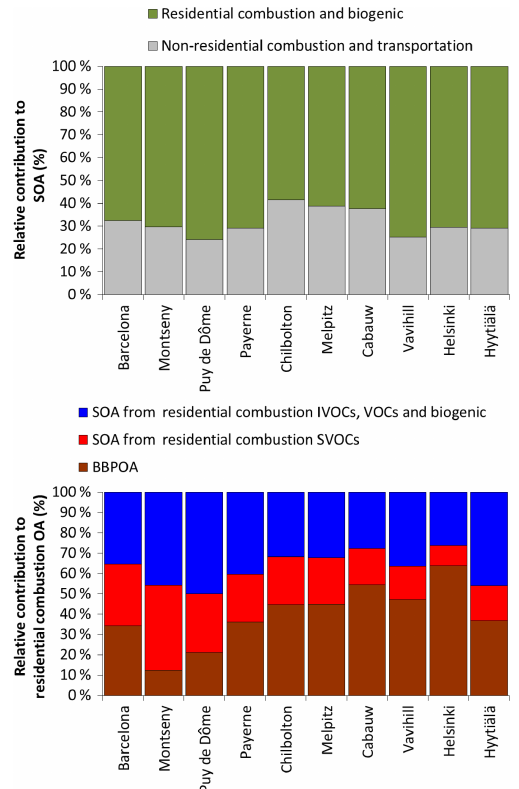
Figure 11. Contribution of residential and non-residential combus- tion precursors to SOA at different sites (upper panel). Contribution of BBPOA, SVOCs and higher-volatility organic precursors to res- idential heating OA (lower panel). Stations are ordered from south to